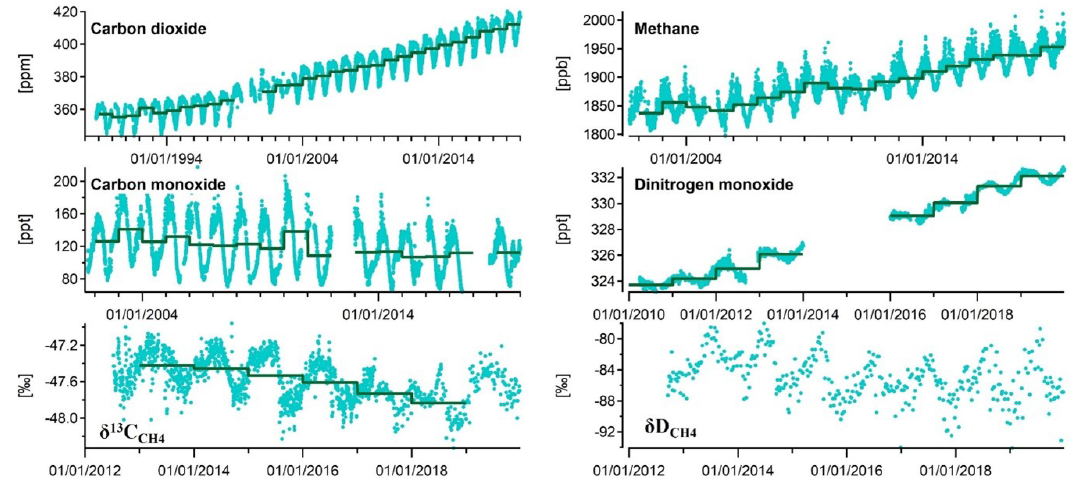
Figure 12. Daily (markers) and annual (solid lines) atmospheric mixing ratios of carbon dioxide (CO 2 ), methane (CH 4 ), carbon monoxide (CO), and dinitrogen monoxide (N 2 O) and isotopic shifts in the carbon and deuterium in methane of carbon-13 ( δ 13 C CH ( δ D CH ) at the Zeppelin Observatory. Daily and annual means calculated only where data coverage is ≥ 75% of the total day or year, 4